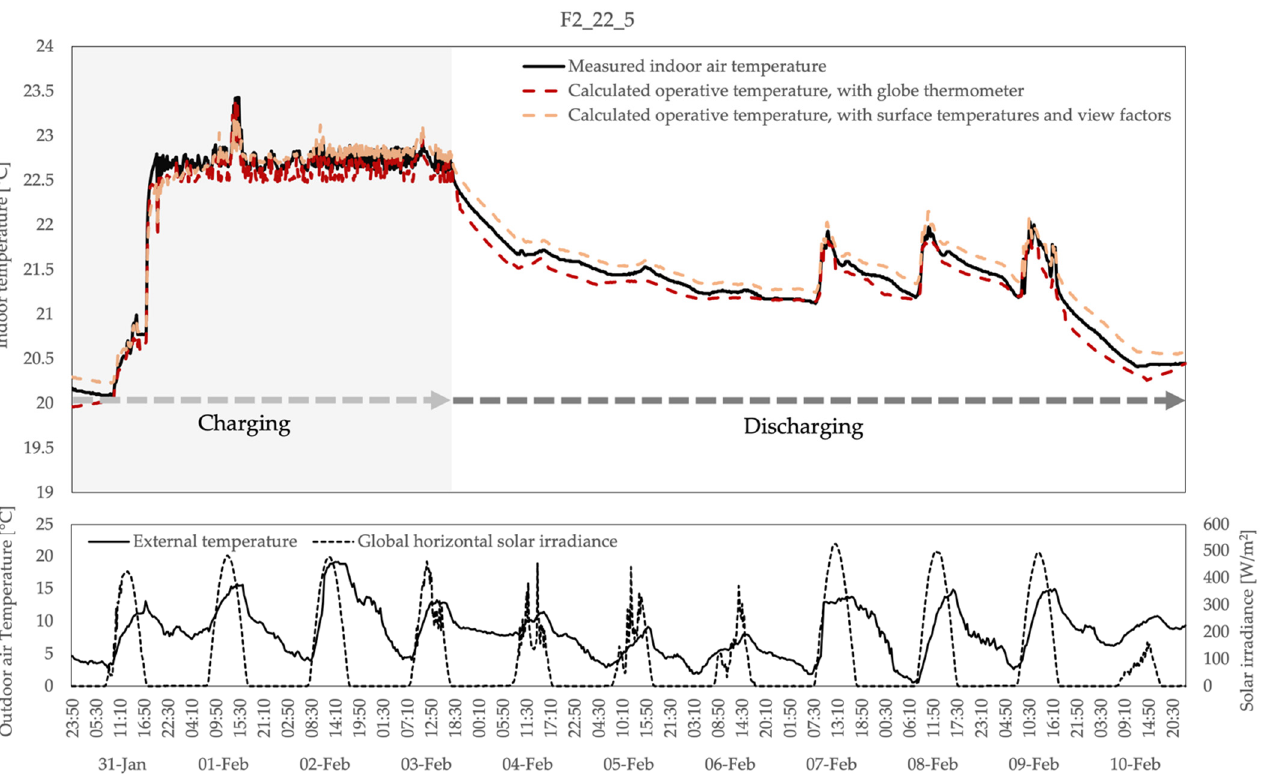
Figure 5. Visualization of the flexibility test through measured and calculated data according to ISO 7726 (Test reference: F2, 3–10 February 2022).